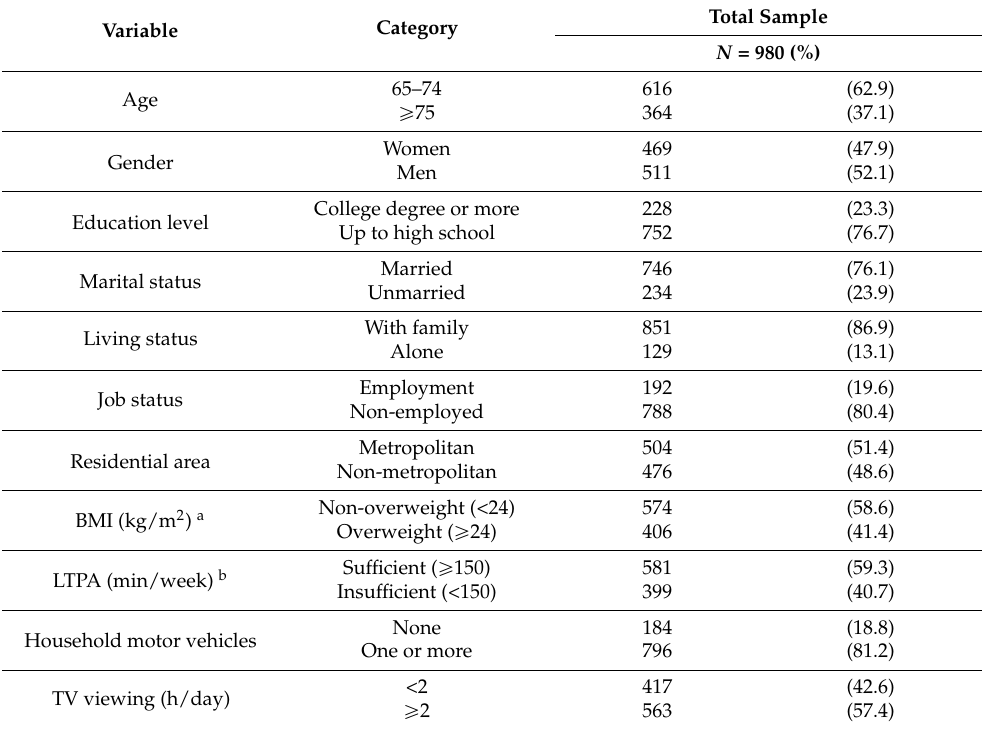
Table 2. Characteristics of